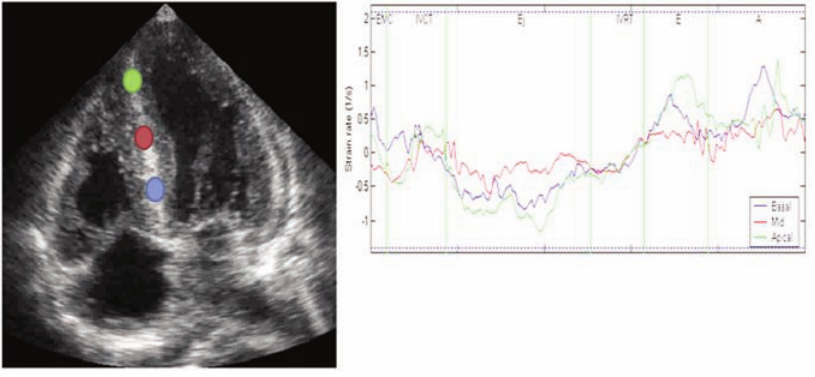
Figure 3. A case of amyloidosis showing reduced myocardial peak systolic strain rate in basal and mid segments, with a relatively preserved deformation at the